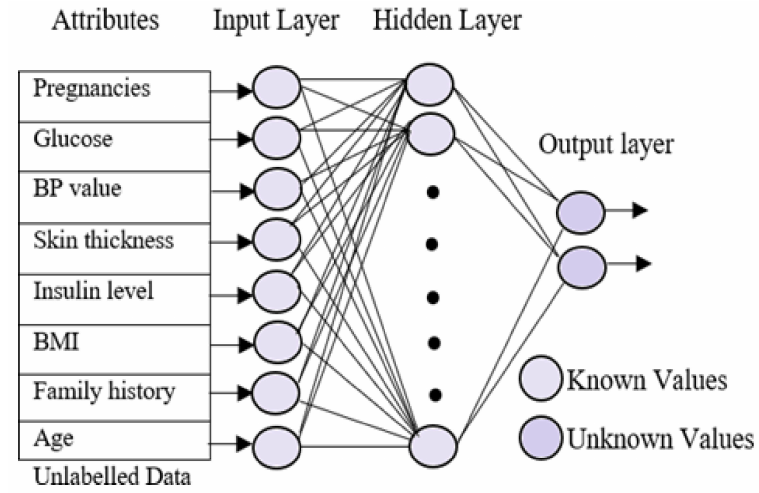
Figure 3. Neural network testing